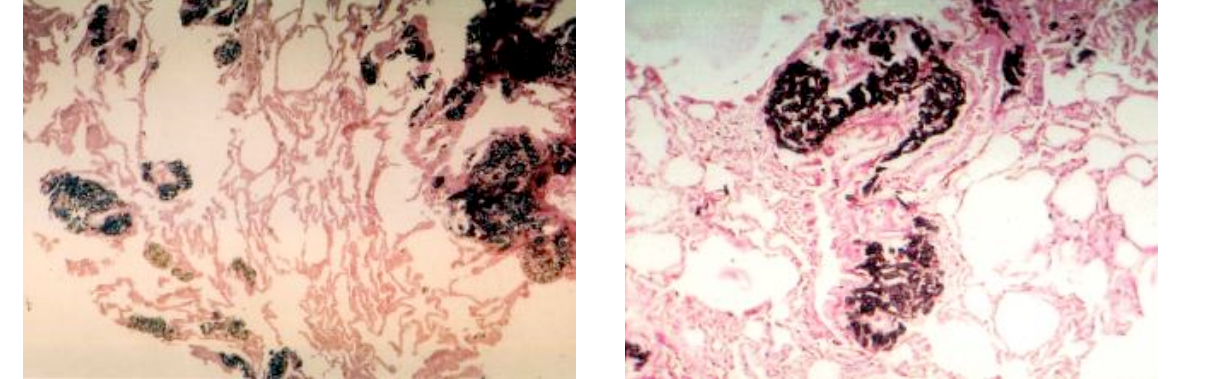
Image 11. Lung of Rhesus Macaque showing granuloma, deposition of carbon particles, Anthracosis, H&E, 87.5x.